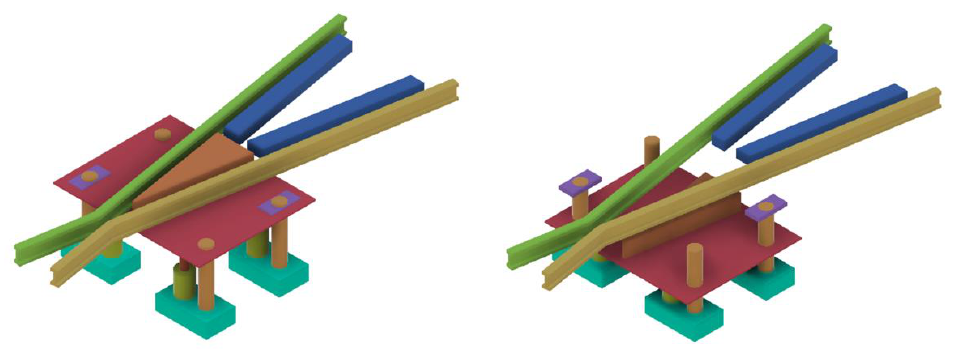
Figure 5. Scheme of the proposed turnout.